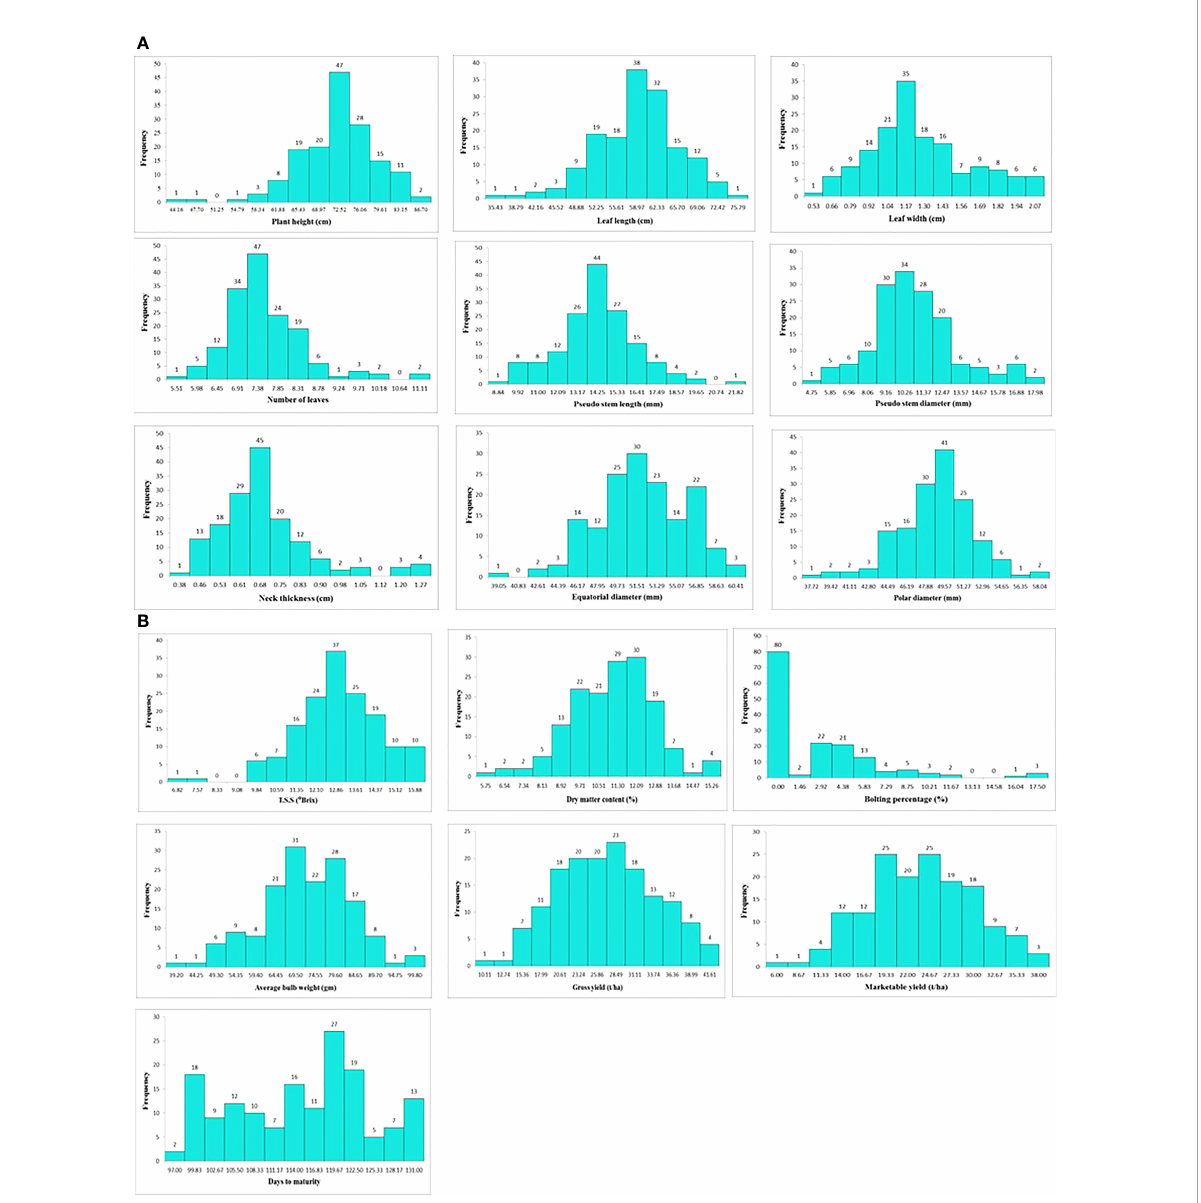
FIGURE 4 (A) Frequency distribution of onion genotypes for various morphological traits. (B) Frequency distribution of onion genotypes for morphological, biochemical, and yield